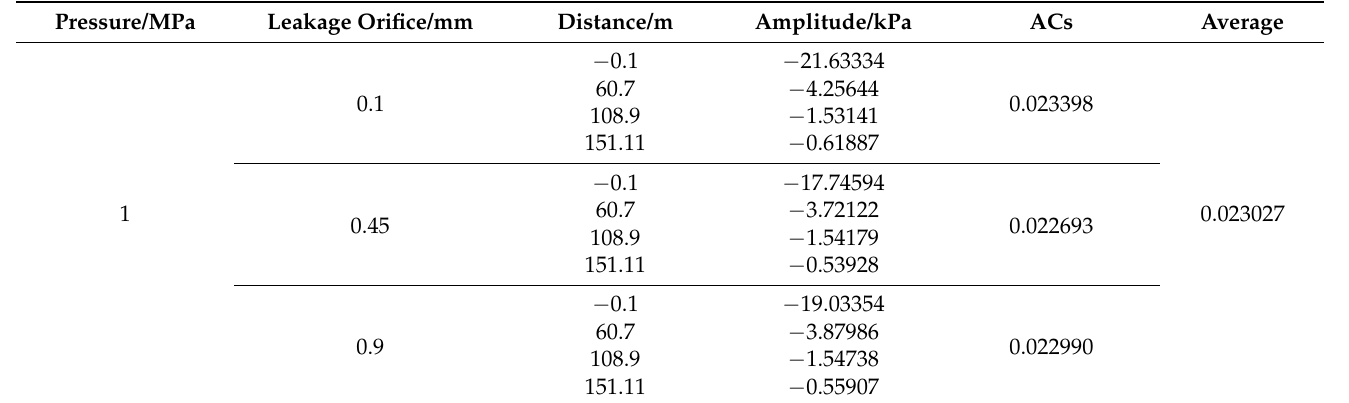
Table 6. The fitted ACs when acoustic waves propagate